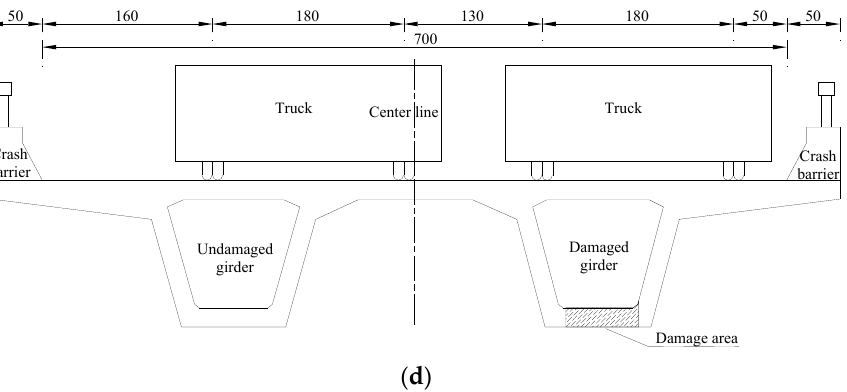
Figure 22. Different types of trucks and transverse layout (Unit: cm). ( a ) Type 1; ( b ) Type 2; ( c ) Type 3; ( d ) Transverse layout.